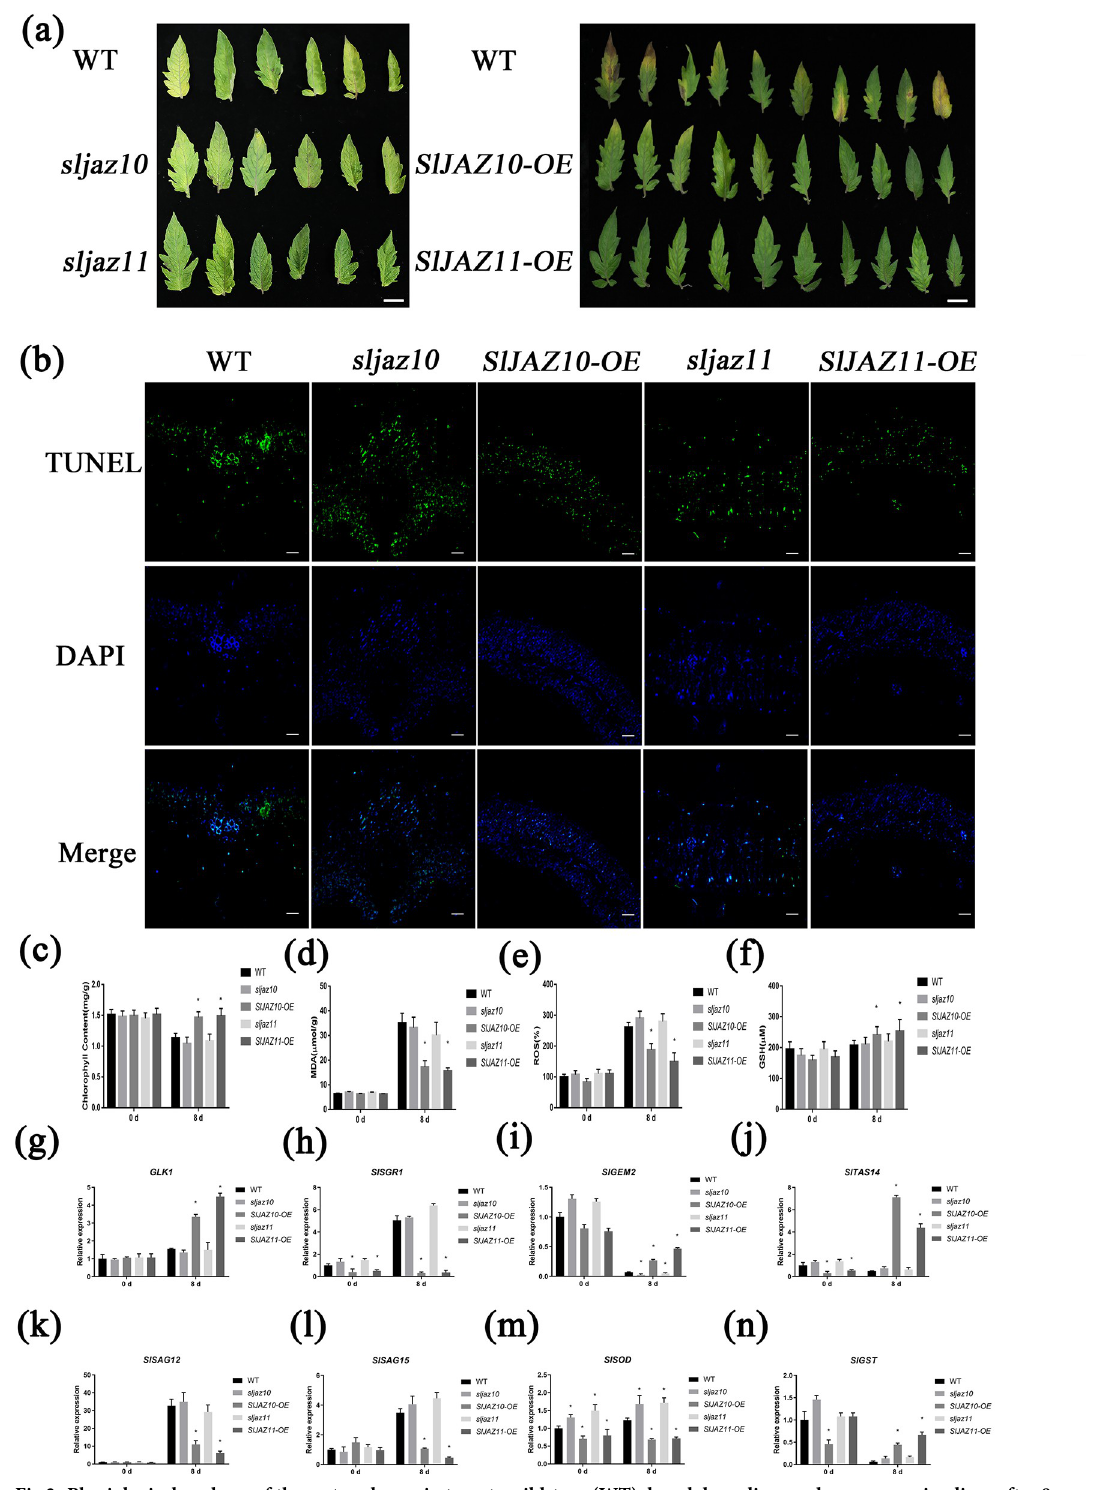
Fig 2. Physiological analyses of the mature leaves in tomato wild-type (WT), knockdown lines and overexpression lines after 8 days dark treatment. (a) Mature leaves of the wild type, knock-out, and overexpression lines under dark treatment, incubated with wetted filter paper in dark conditions for 8d, and photographed. (b) Cell death was detected using the Tunel assay. Representative images show Tunel staining results (blue, DAPI; green, Tunel). (c-f) Contents of chlorophyll, MDA, ROS and GSH in the leaves of